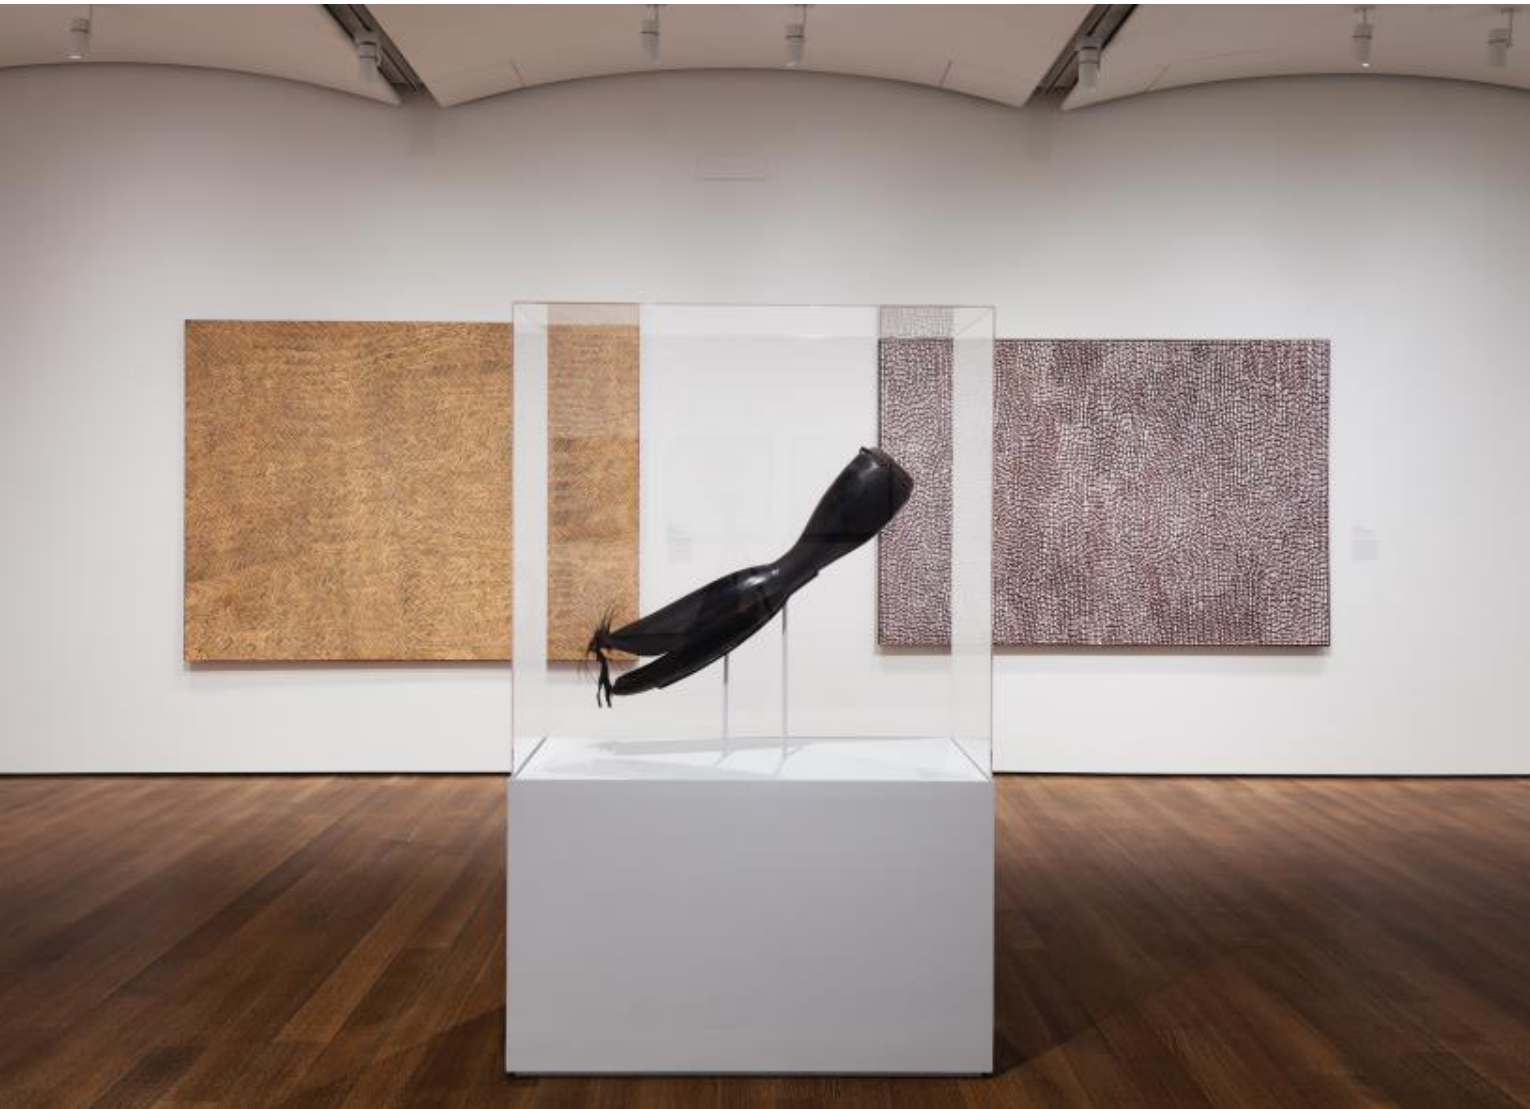
Installation view of “Performance” module from Everywhen: The Eternal Present in Indigenous Art from Australia, Harvard Art Museums, Cambridge, MA, curated by Stephen Gilchrist. Works left to right: Doreen Reid Nakamarra, Untitled , 2007; Unidentified artist, Warup (Drum) , mid-19th — early 20th century; and Dorothy Napangardi, Karntakurlangu Jukurrpa , 2002. Image Courtesy Harvard Art Museums, © President and Fellows of Harvard